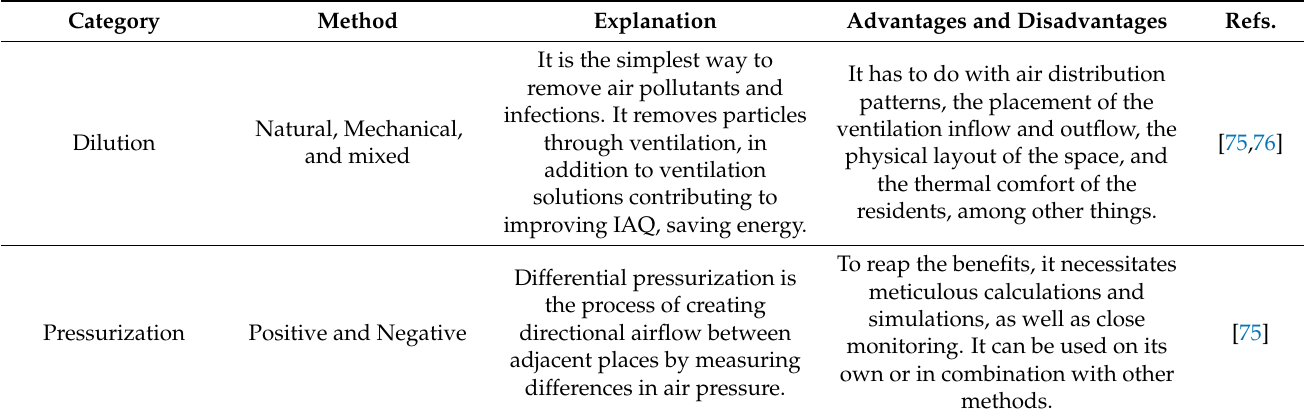
Figure 9. Computer simulation at Oregon University displaying the possible spread of COVID-19 in a restaurant with an air recirculation system (Adapted from [74]). Table 1. Purification systems and air disinfection